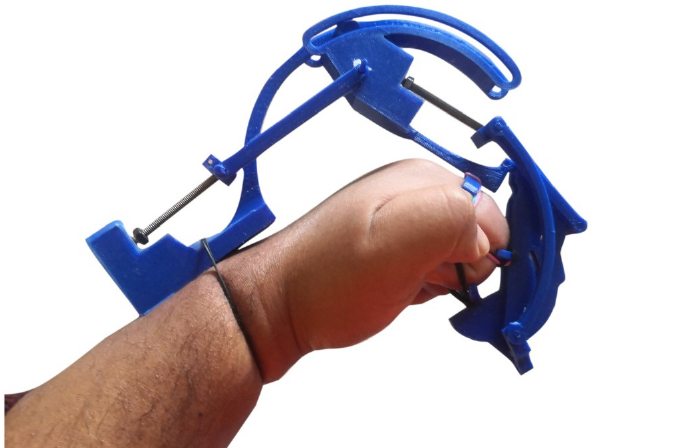
Figure 5. Three-dimensional-printed prototype for Subject